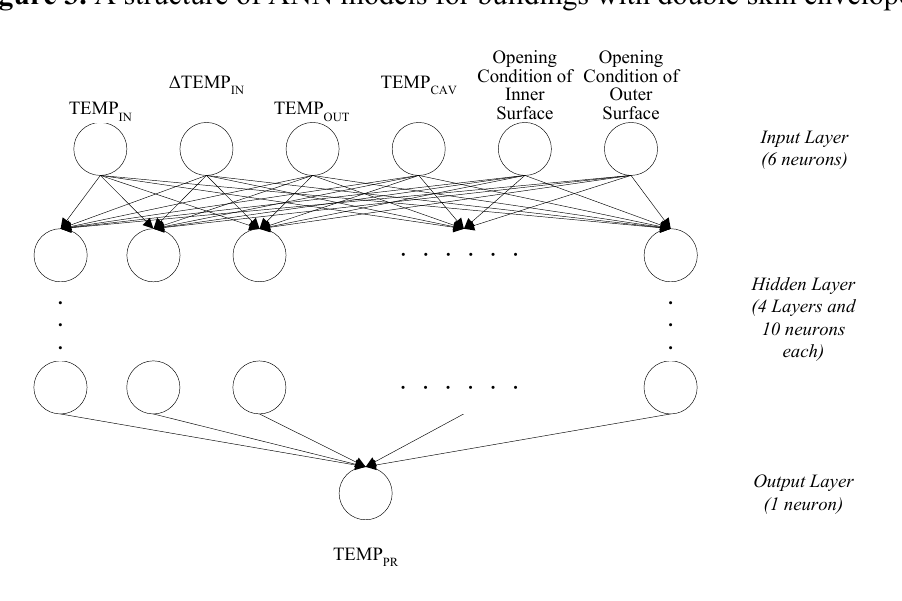
Figure 4. A structure of ANN models for buildings with single skin